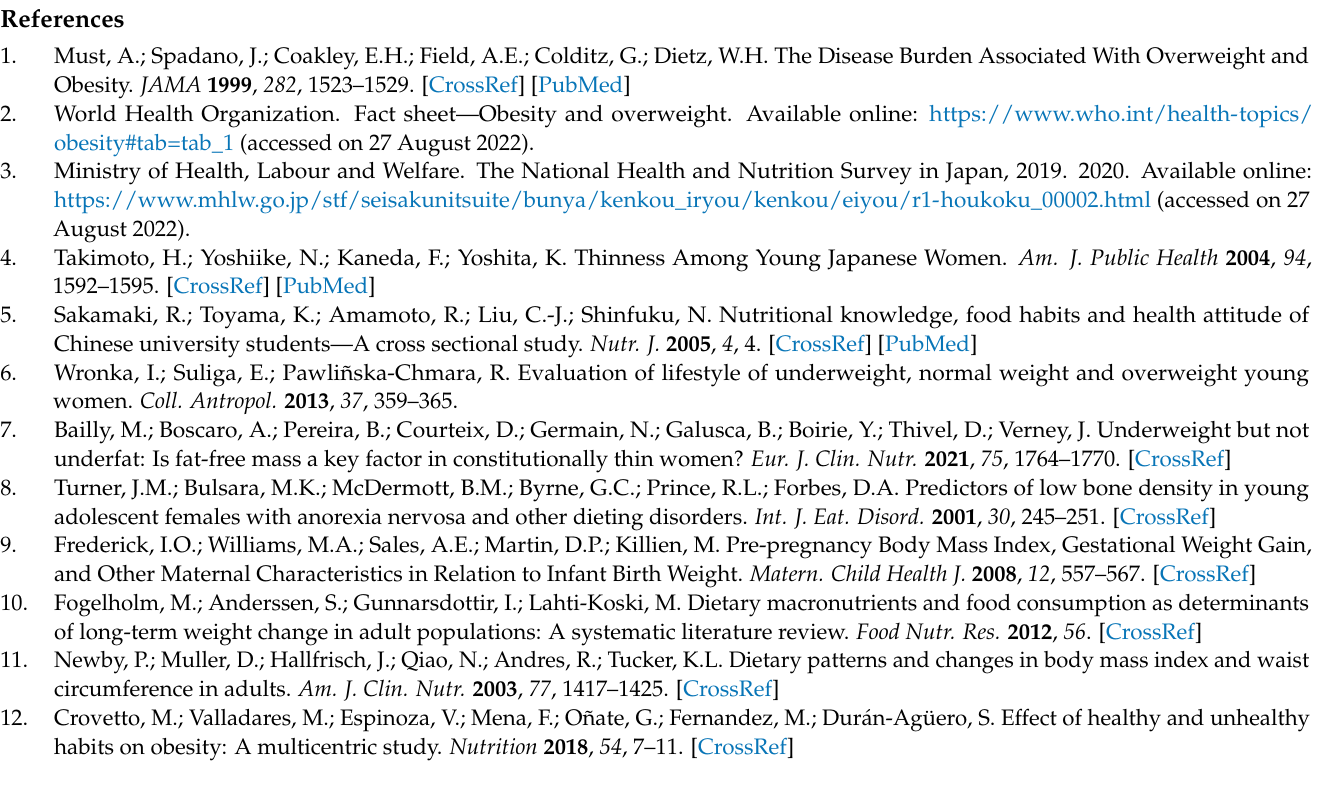
Table S2: Trends in food group intakes among young Japanese women classified as underweight, normal and obese between 2001 and